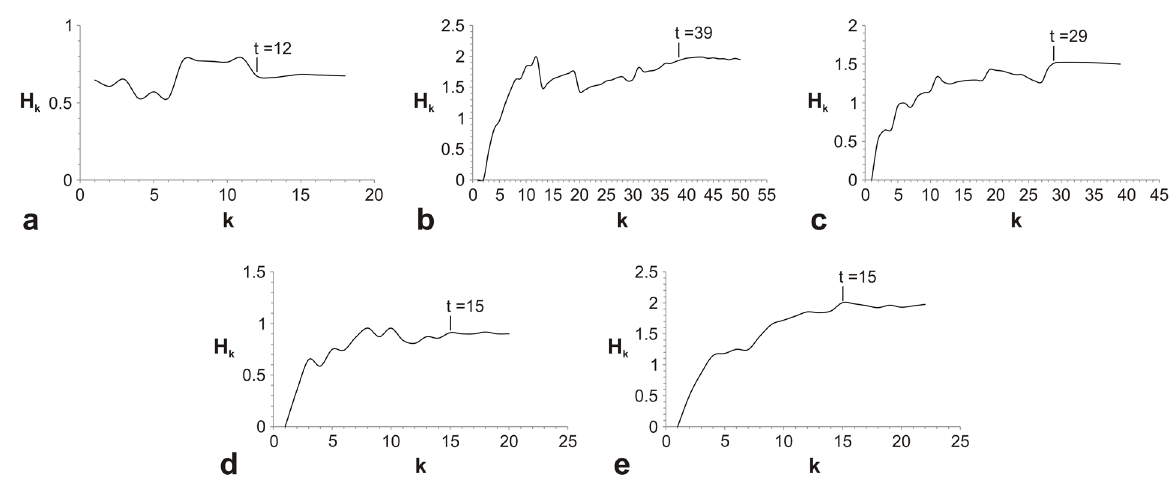
Figure 2. Minimum sample size determination for Epictia australis (a), Erythrolamprus poecilogyrus (b), Lygophis elegantissimus (c), Philodryas patagoniensis (d), and Bothrops alternatus (e). Hk = accumulated trophic diversity, k = number of stomachs, t = minimum sample